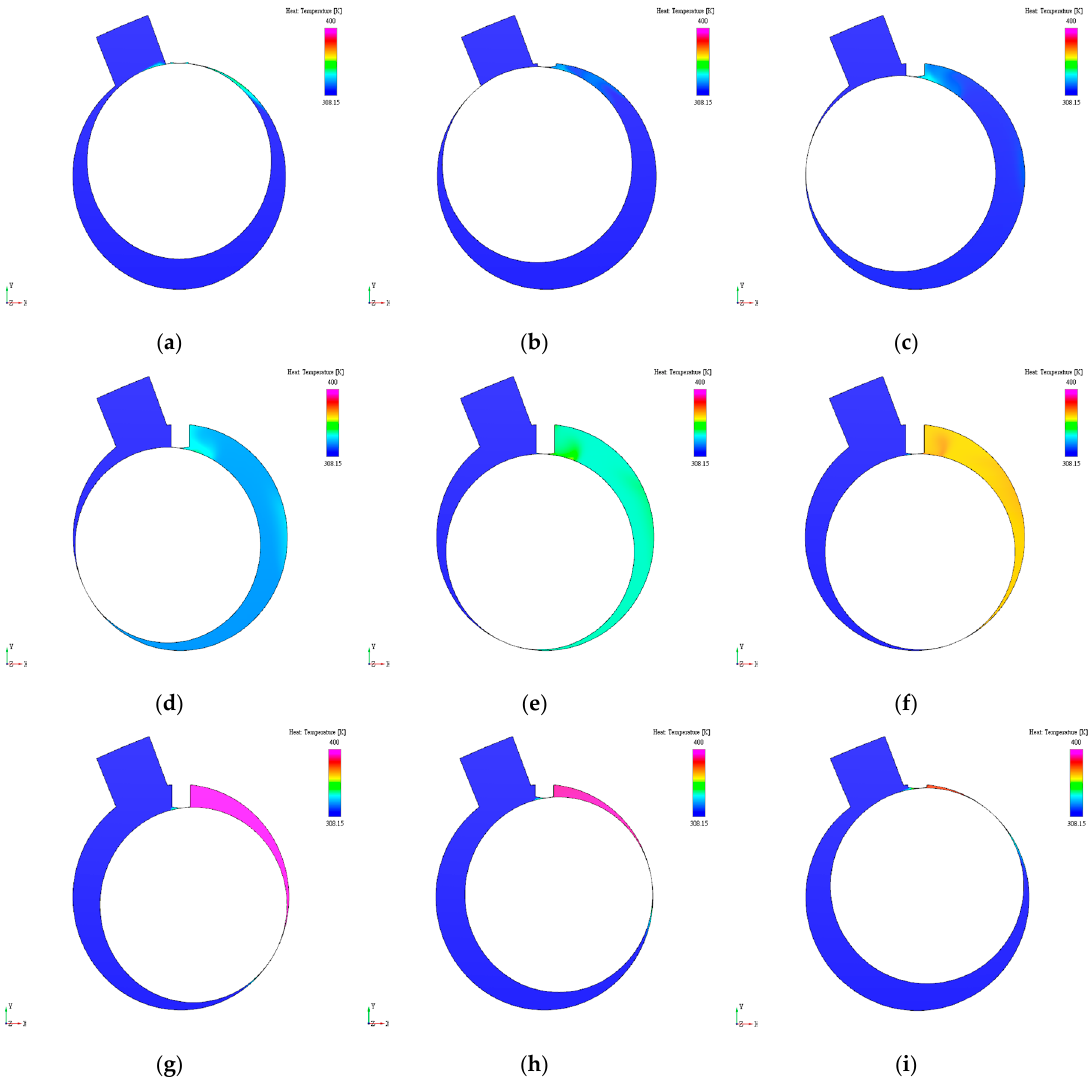
Figure 6. Temperature distribution at different rotation angles of piston: ( a ) 0°, ( b) 40°, ( c ) 80°, ( d ) 120°